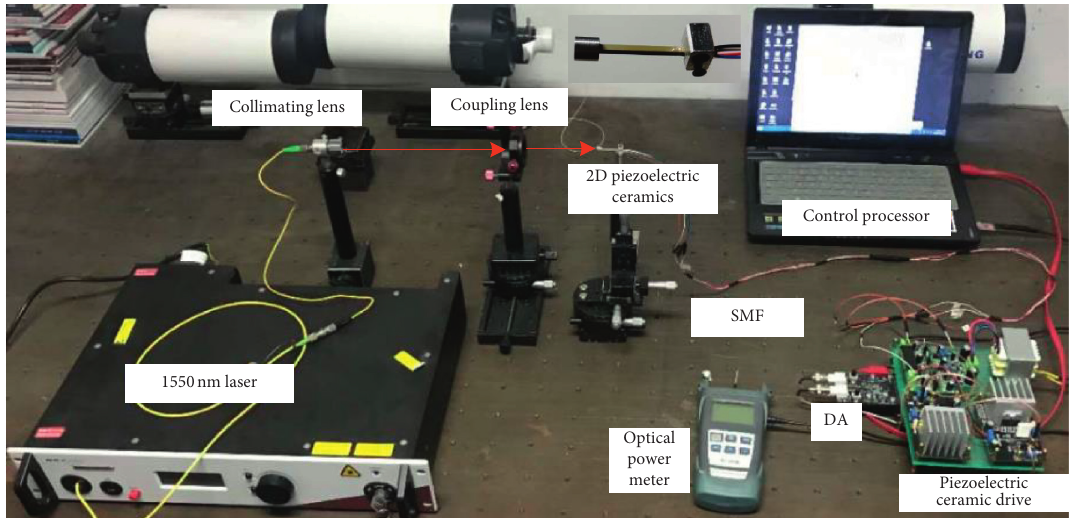
Figure 7: Physical image of the spatial light-fiber coupling automatic alignment